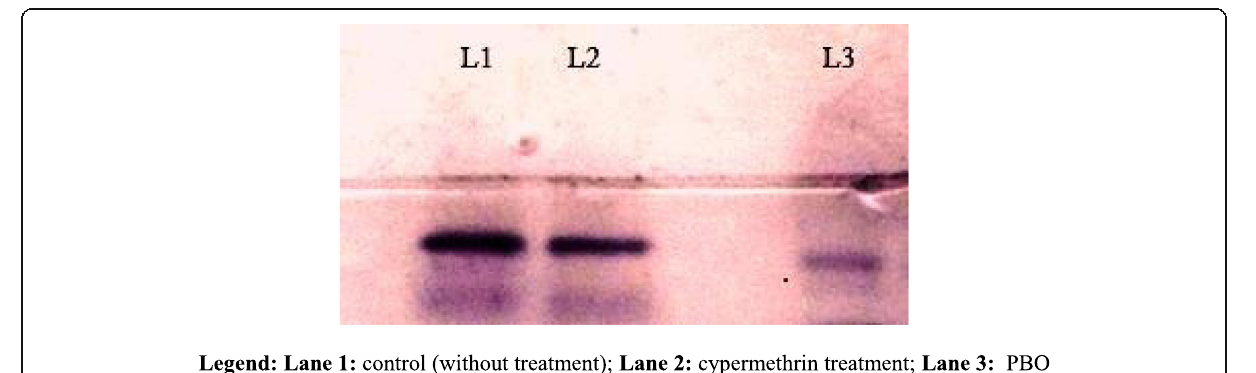
Fig. 5 In vitro inhibition of AChE isoenzyme, resolved by native polyacrylamide gel electrophoresis (PAGE), to 5 mM concentrations of PBO, before staining with acetyl thiocholine iodide (ATC) substrate. Legend: Lane 1: control (without treatment); Lane 2: cypermethrin treatment; Lane 3: PBO inhibitor (5